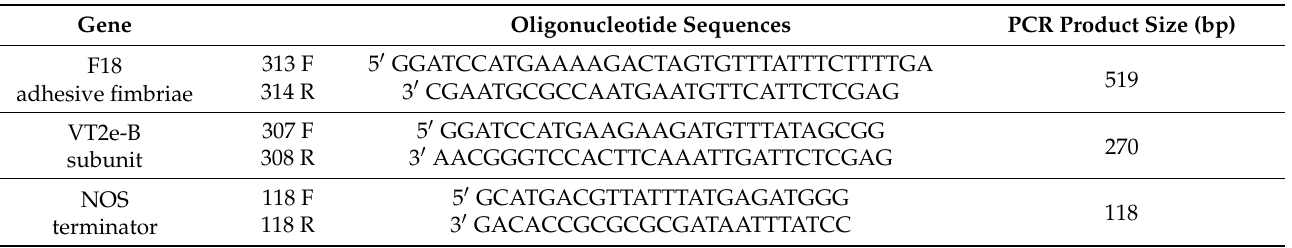
Table 7. Oligonucleotides used for PCR assays to detect engineered and wild-type tobacco seed lines. Gene Oligonucleotide Sequences PCR Product Size